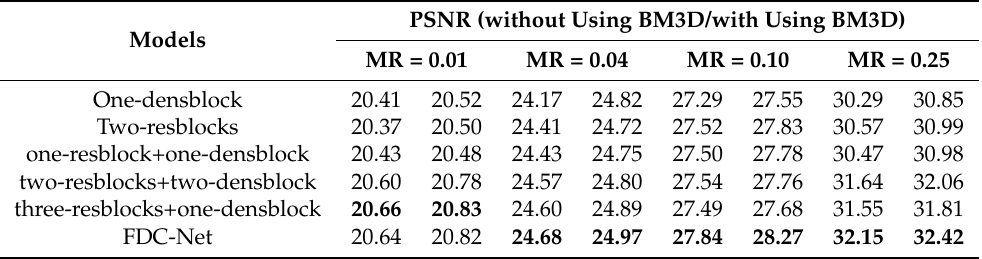
Table 3. Performance comparison among different network architectures.